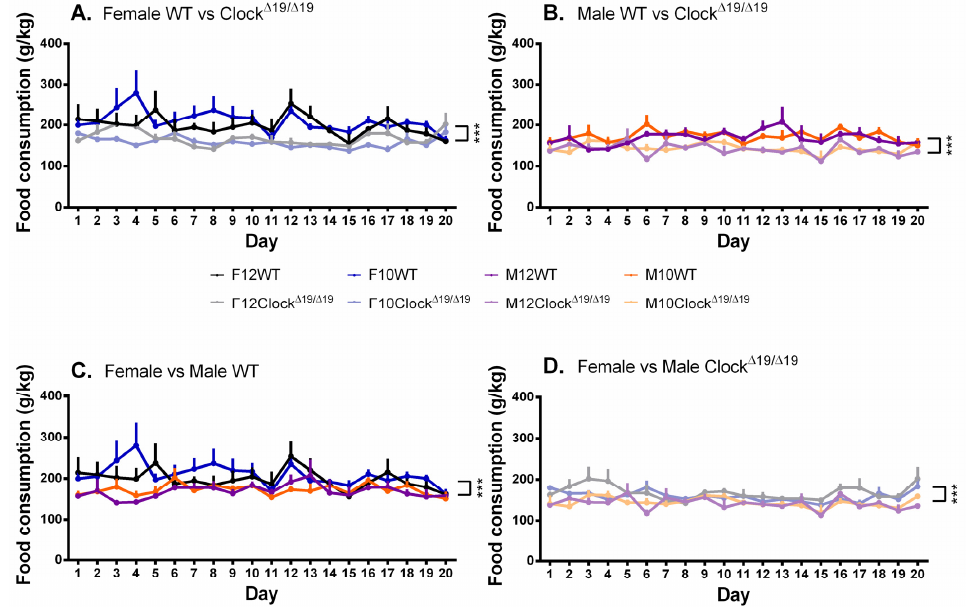
Figure 6. The amount of food consumed by mice is influenced by sex and genotype. ( A ). Female WT mice consumed more food across the 20-day testing period than female Clock Δ 19/ Δ 19 mice. ( B ). Male WT mice consumed more food across the 20-day testing period than male Clock Δ 19/ Δ 19 mice. ( C ). Female WT mice consumed more food than male WT mice across the 20-day testing period. ( D ). Female Clock Δ 19/ Δ 19 mice consumed more food than male Clock Δ 19/ Δ 19 mice across the 20-day testing period. F = females, M = males; 12 = 12:12 L:D cycle, 10 = 10:10 L:D cycle; WT = wild-type. Darker tones are WT mice and lighter tones are Clock Δ 19/ Δ 19 mice. Black = female 12:12 L:D group, blue = female 10:10 L:D group, purple = male 12:12 L:D group, orange = male 10:10 L:D group. *** = p < 0.001.